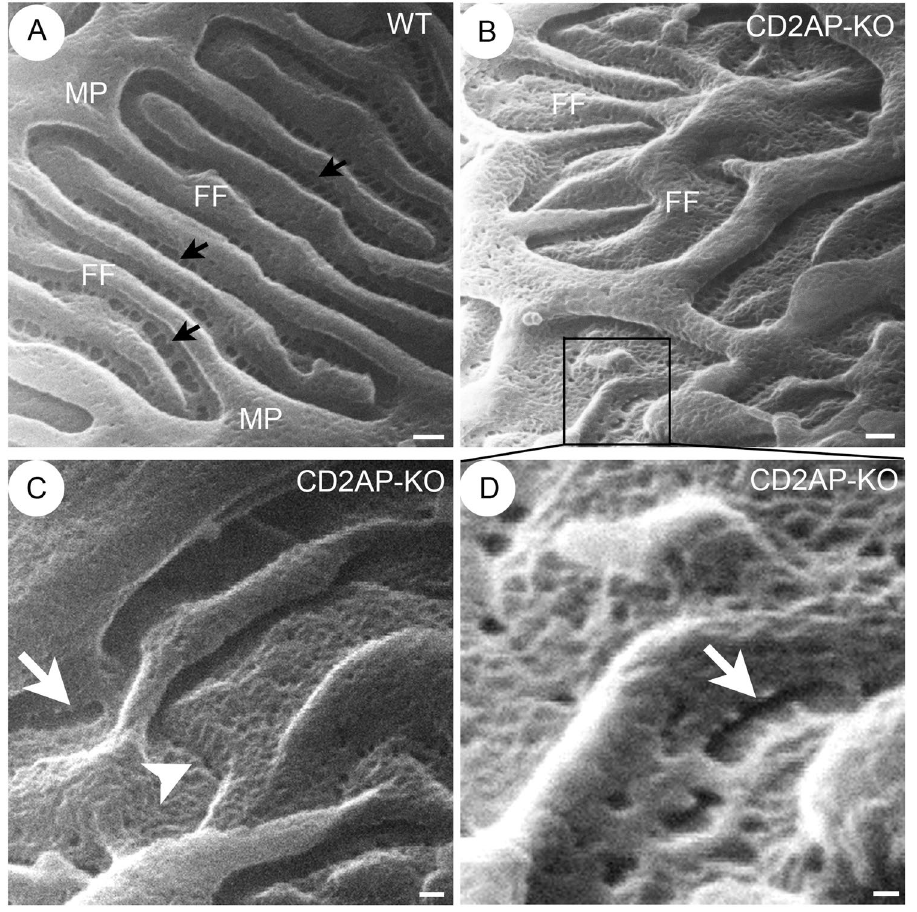
Figure 6. Foot process and filtration slit in WT and CD2AP deficient mice by HIM. HIM images of foot processes and SDs in WT ( A ) and 3 week-old Cd2ap -KO ( B – D ) kidney. Image of WT ( A ) shows interdigitated foot processes forming evenly spaced filtration silts. The slit pores (black arrows) line up and form a ladder-like pattern in the middle of the filtration slit and between adjacent foot processes. Image of Cd2ap -KO kidney ( B ) shows the disorganized and irregular orientation/alignment of primary process and foot processes. Foot process branching appears more random, and foot processes show flattened and widened ( B ). The “gaps” between disrupted SDs in some areas are detectable (white arrows, C , D ). The junction between foot processes appears closed in some areas (white arrowhead, C ). Scale bars, 100 nm ( A , B ); 50 nm ( C , D ). MP, major process; FF, foot